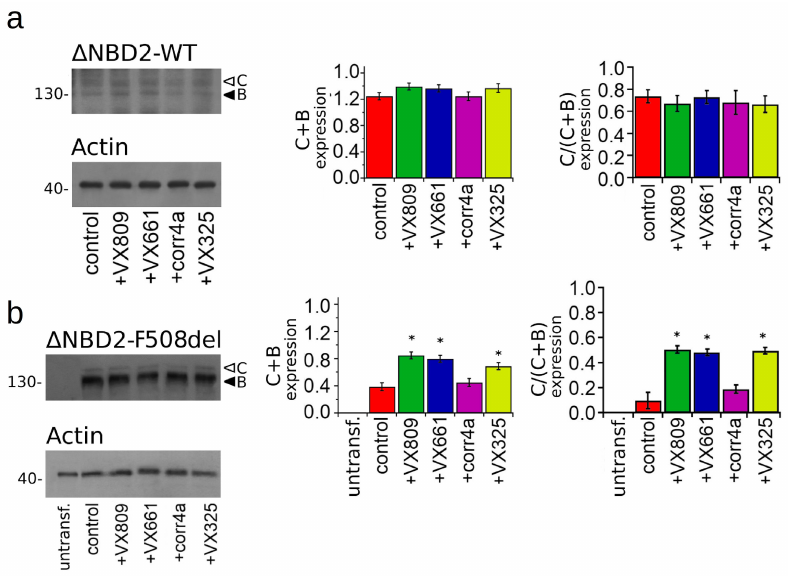
Figure 6. Biochemical analysis of WT- and F508del- ∆ NBD2 expression pattern. ( a ) Electrophoretic mobility of WT- ∆ NBD2 in untreated HEK-t cells (control) or treated for 18 h with the VX809, VX661, corr4a and VX325 correctors. ( b ) Expression of F508del- ∆ NBD2 in untransfected (untransf.) and transiently transfected cells after 18 h of treatment with DMSO (control) or with 5 µ M VX809, 5 µ M VX661, 10 µ M corr4a and 5 µ M VX325. Arrowheads indicate the fully-glycosylated (C band), the core-glycosylated (B band), and the unglycosylated, immature forms of the ∆ NBD2 proteins. In the lower blots, the expression of actin, used as housekeeping protein, is shown. The molecular weight of the proteins of molecular weight marker that was run in the SDS-PAGE is indicated on the left of each blot. Bar graphs in the middle show the quantification of the total ∆ NBD2 protein expression, calculated as the sum of the B and C bands, normalized by the actin expression. Bar graphs on the right indicate the quantification of the mature, fully glycosylated fraction of the ∆ NBD2 protein, expressed as the C / (C + B) band ratio. Data are expressed as mean ± SEM of at least four independent experiments. Statistical significance was tested by Dunnet multiple comparisons test (all groups against the control group). Asterisks indicate statistical significance versus DMSO: * p <